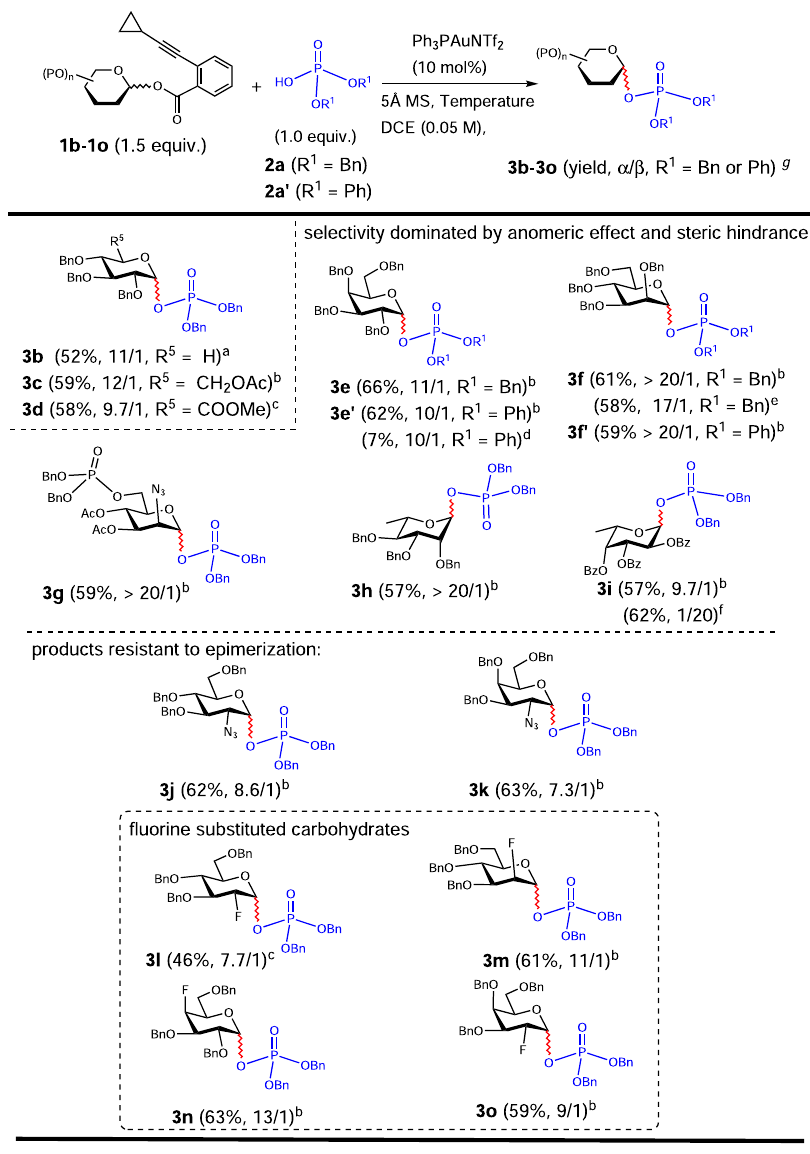
Fig. 3 The reaction scope of various glycosyl donors. a Temperature: 0 °C, 30 min then 60 °C, 2 h. b Temperature: 0 °C, 30 min, then 20 °C, 2 h. c Temperature: 0 °C, 30 min, then 100 °C, 2 h. d galactosyl trichloroacetimidate was used as donor in the presence of TMSOTf (0.1 equiv.) at 0 °C in 30 min. e On 1.2 g scale with 0.5 mol% Ph f 0.2 equiv. of i- Pr g Yields of α / β mixtures ( α / β mixtures were not separable, 3 PAuNTf 2 . 2 NEt was used as additive.